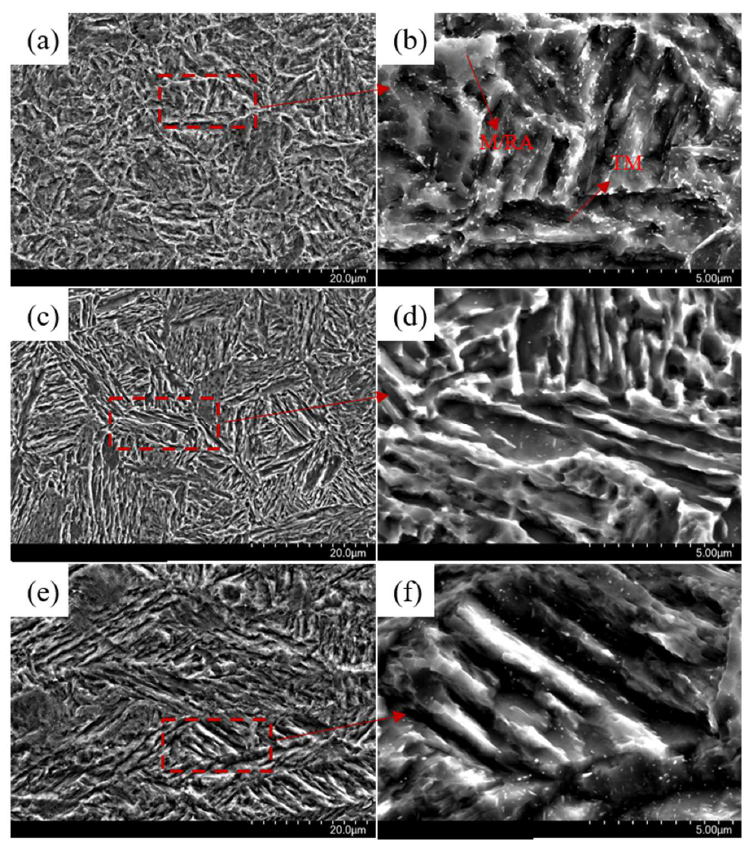
Figure 7. ( a , c , e ) are SEM images of the three processes of QP-300, IA-680, QA-680; ( b , d , f ) are the partial enlarged images of ( a , c , e ). partial enlarged images of ( a , c , e